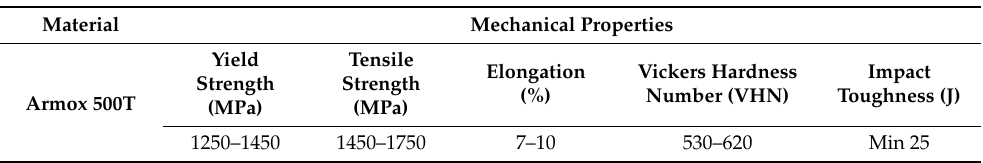
Table 3. The mechanical properties of standard material (Armox 500T) used for potential armoring